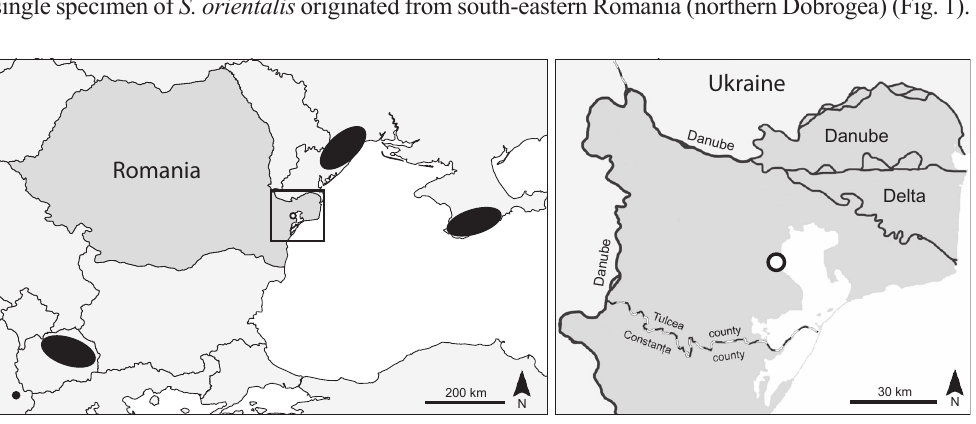
Figure 1. Left panel – geographic location of the Romanian record of S. orientalis and the nearest known areas of occurence for this species (black ovals and dot). Right panel – detail of the location (black circle) of the Romanian record of S. orientalis , Enisala fortress, Tulcea